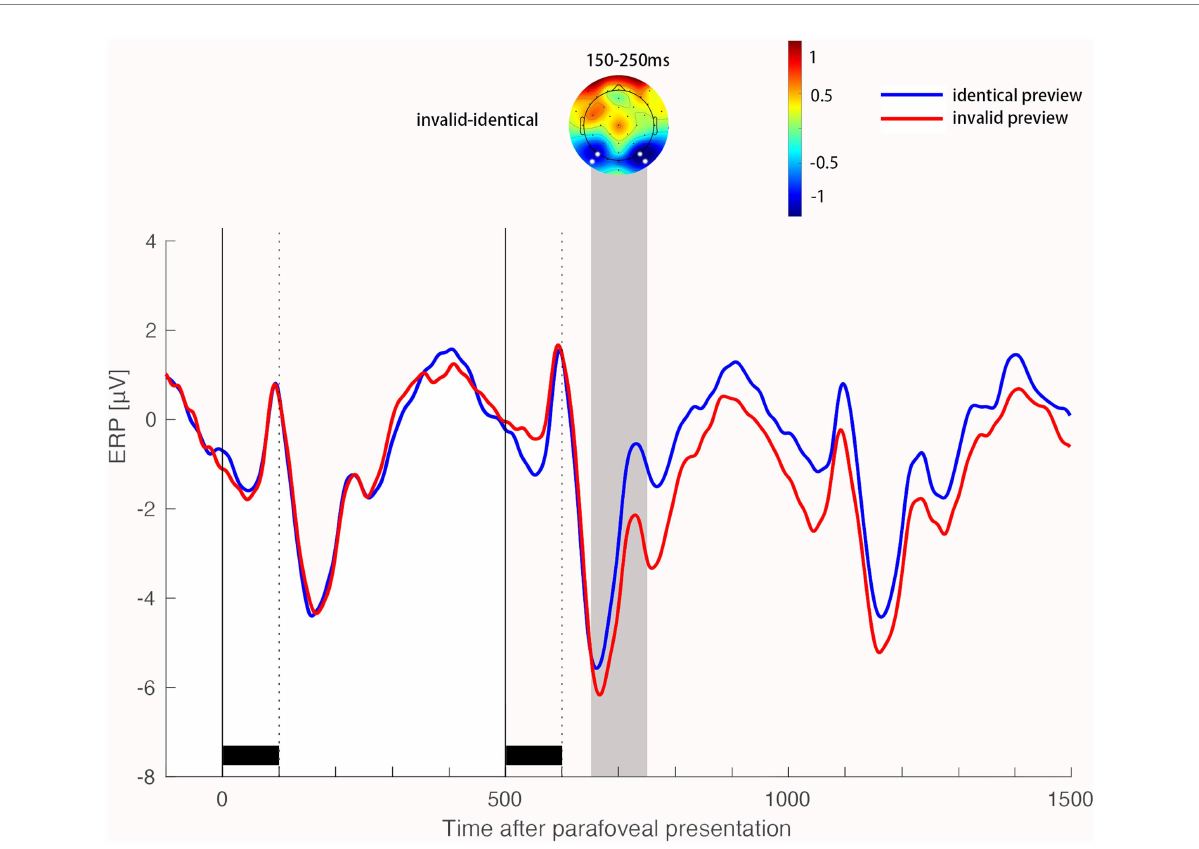
FIGURE 3 Main effect of preview identity on the early preview positivity at occipitotemporal electrodes. Time 0 on the time axis marks the onset of the target word in the right parafoveal position. Black bars above the time axis mark the stimulus durations of the character triads. The two vertical lines mark the onset of the triad containing the target word in the parafovea and fovea, respectively. ERP waveforms show the average activity in the ROI of four electrodes (highlighted in white in the topographic map) for the identical preview condition and invalid preview condition. Scalp topographic map shows the difference in ERP activity (invalid preview conditions minus identical preview conditions) in the time window of 150–250 ms after the onset of the word in the foveal